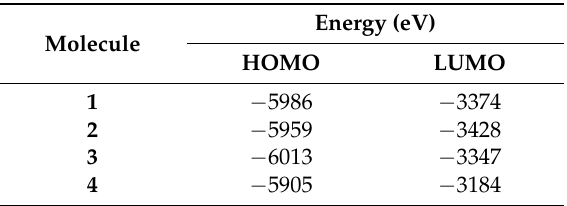
Table 1. E HOMO and E LUMO of the studied molecules. Table 1 . E HOMO and E LUMO of the studied molecules. Table 1 . E HOMO and E LUMO of the studied molecules.